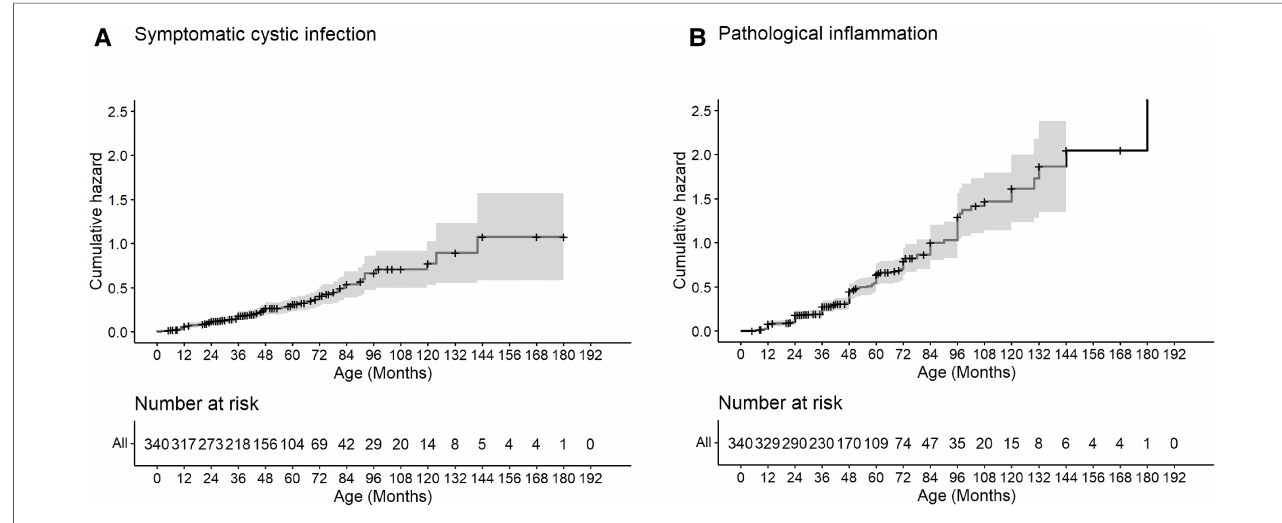
FIGURE 3 Cumulative hazard of symptomatic cystic infection and pathological in fl ammation. Kaplan – Meier analysis for the cumulative hazard of symptomatic cystic infection ( A ) and cumulative incidence of pathological in fl ammation ( B ) with age.